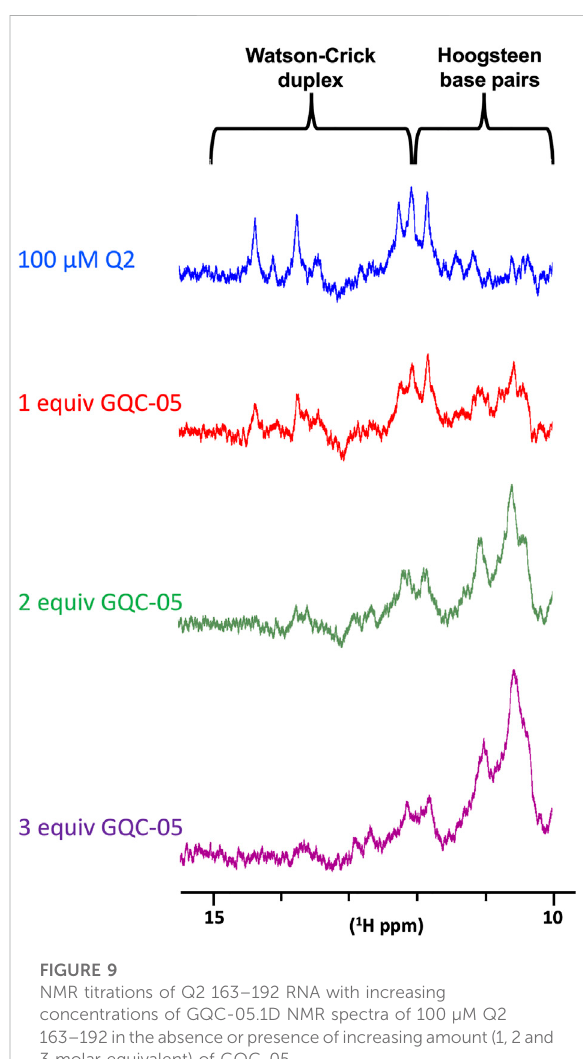
FIGURE 9 NMR titrations of Q2 163 – 192 RNA with increasing concentrations of GQC-05.1D NMR spectra of 100 µM Q2 163 – 192intheabsenceorpresenceofincreasingamount(1,2and 3 molar equivalent) of